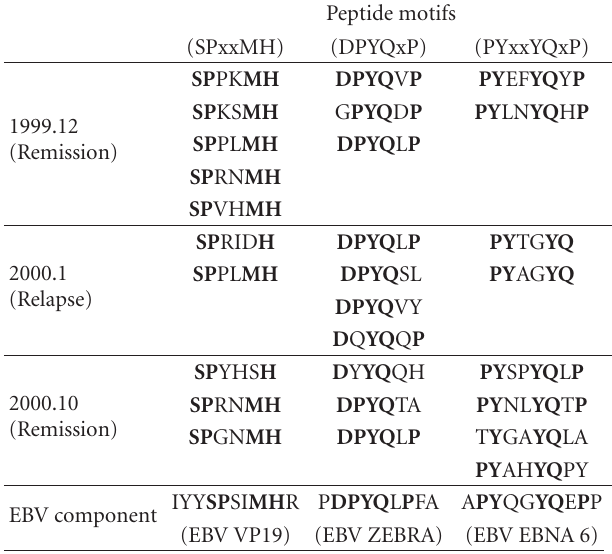
Parentheses indicate common peptide motifs in a control case. Peptide sequences derived from random peptide library are listed below. Table 3: Common peptide motifs derived from 3 CSF samples of